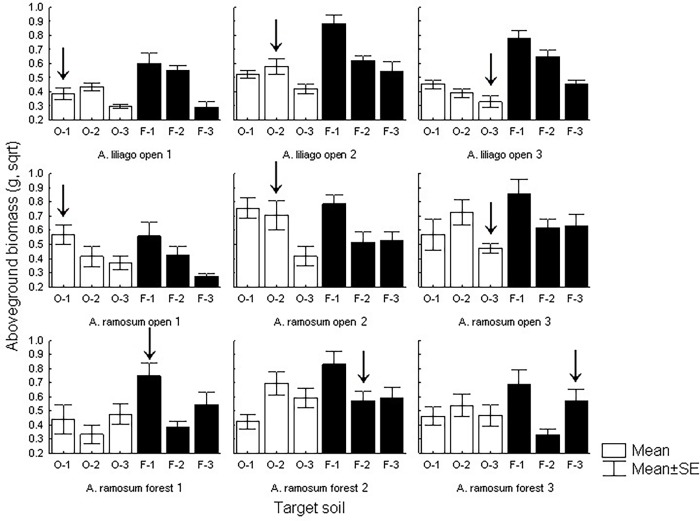
The effect of species, locality of origin and target soil on aboveground biomass.Single panels represent single plant populations (single locality of origin) grown in the common garden. O-1, O-2, O-3, F-1, F-2 and F-3 represent target soils. The target soils either come from open (O, white columns) or forest (F, black columns) environments. The origin and target numbers denote the locality of the population or the soil and correspond to Fig. 1. Arrows indicate plants grown in their home soil.